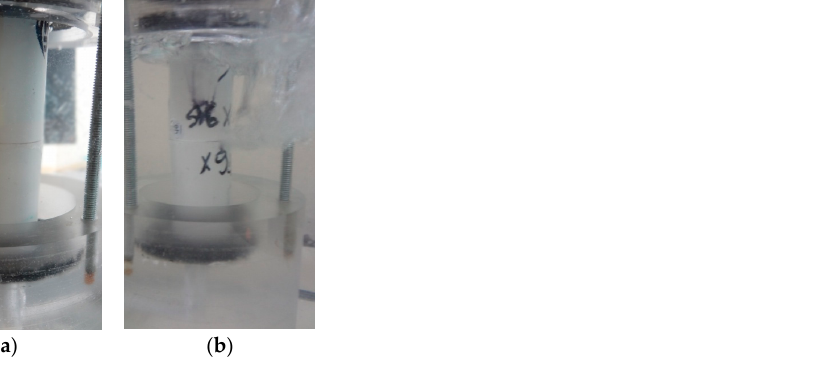
Figure 5. View of sample of adhesive joint (PVC-26.5): ( a ) leak-proof sample made by Loctite 3430 A&B Hysol adhesive; ( b ) leaky sample made by Loctite 406.